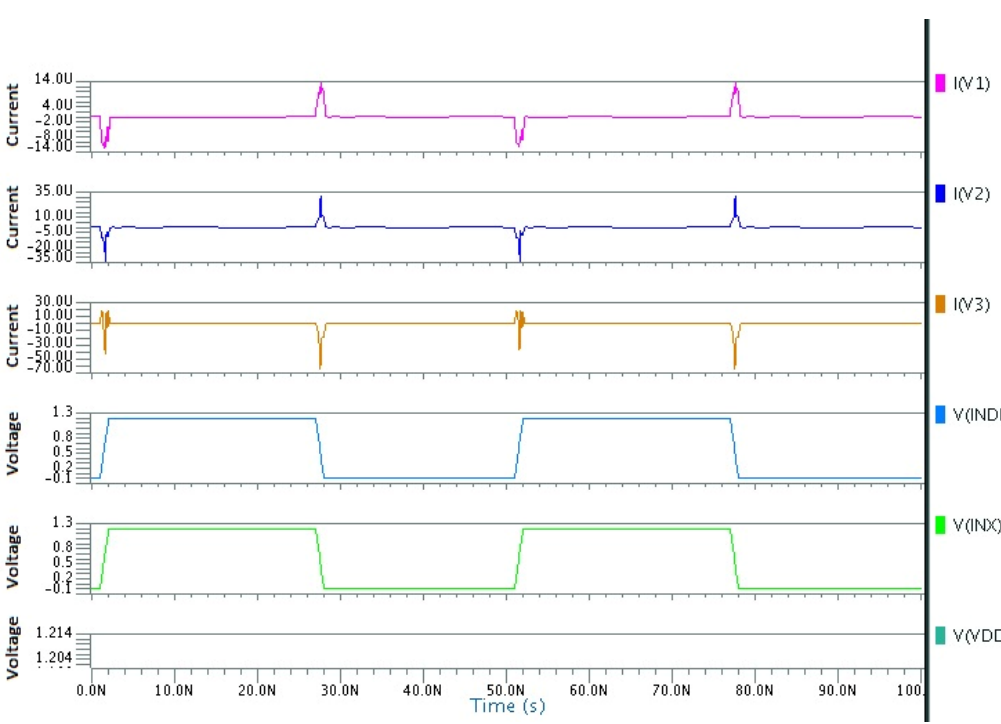
Figure 10. Current profile of the C ‐ element.